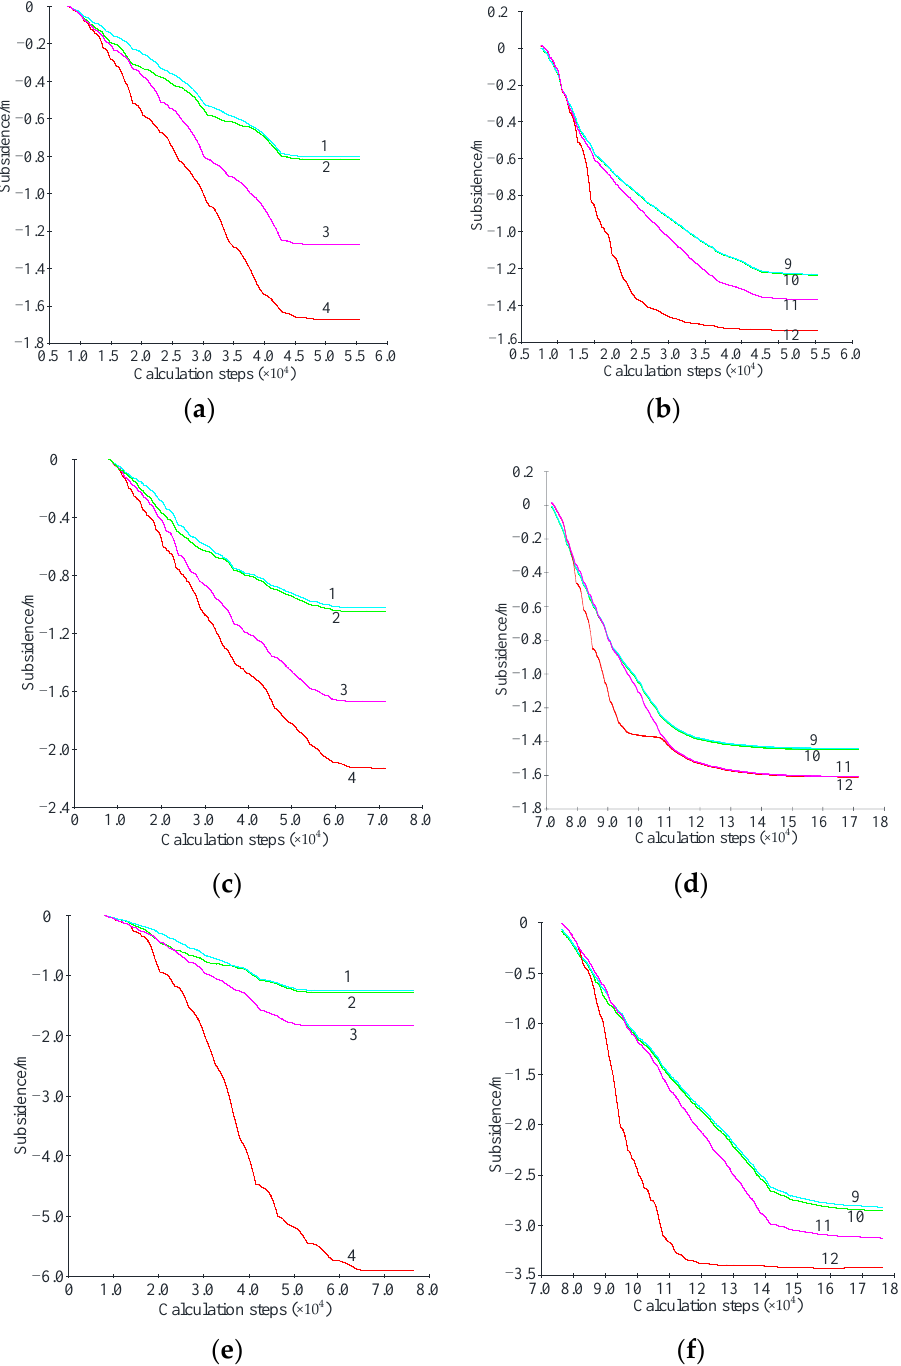
Figure 16. Strata movement due to mining with different mining heights (see Figure 14 for the line number). ( a ) Face No.1, mining height 4 m; ( b ) Face No.2, mining height 4 m; ( c ) Face No.1, mining height 6 m; ( d ) Face No.2, mining height 6 m; ( e ) Face No.1, mining height 8 m; ( f ) Face No.2, mining height 8 m